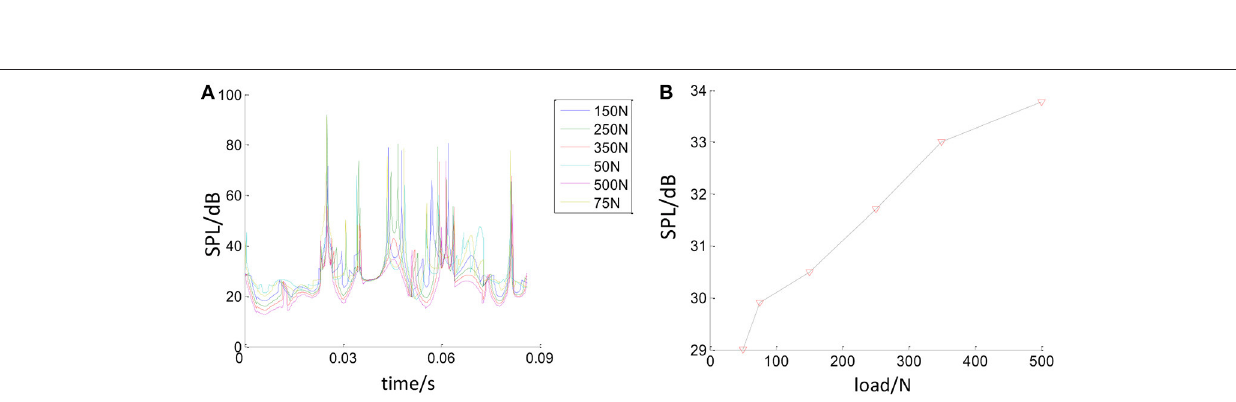
FIGURE 19 | The relationship between bearing load and bearing SPL. (A) Effect of load on bearing SPL. (B) Effect of Load on average bearing SPL.